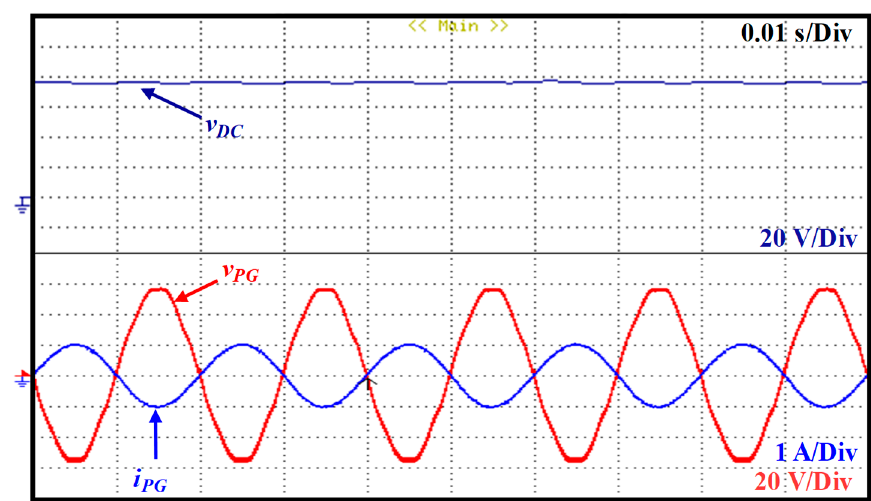
Figure 19. Experimental results of the developed multifunctional isolated microinverter: oltage at the DC-link ( v DC ), voltage ( v PG ) and current ( i PG ) on the power grid.